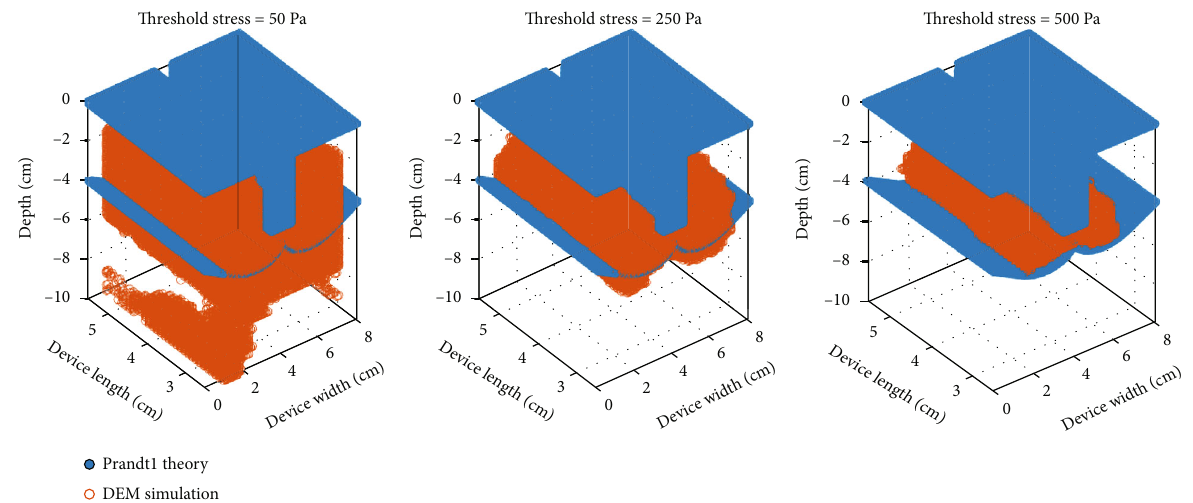
Figure 9: Selection of stress monitor size.